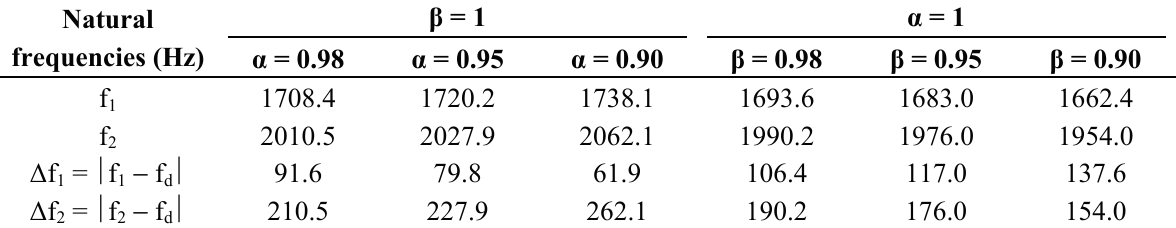
Table 2. Change of the natural frequencies with nonideal α or β